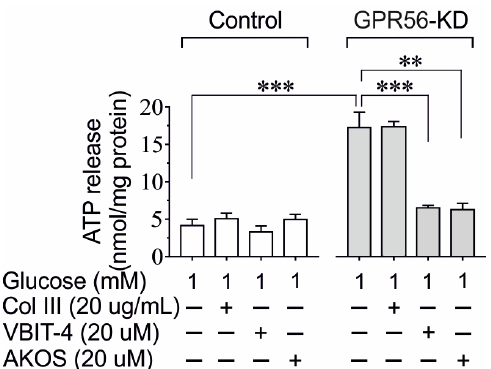
Figure 5. The effect of Coll III and VDAC1 inhibitors (VBIT-4 or AKOS) on ATP release in scramble control and Gpr56-KD INS-1 832/13 cells. The INS-1 832/13 cells were incubated at 1 mM of glucose in the presence or absence of Coll III, VBIT-4, or AKOS022075291 (AKOS) for 1 h. Mean ± SEM for n = 5 experiments performing at different occasions are shown. **, p < 0.01; ***, p < 0.001.